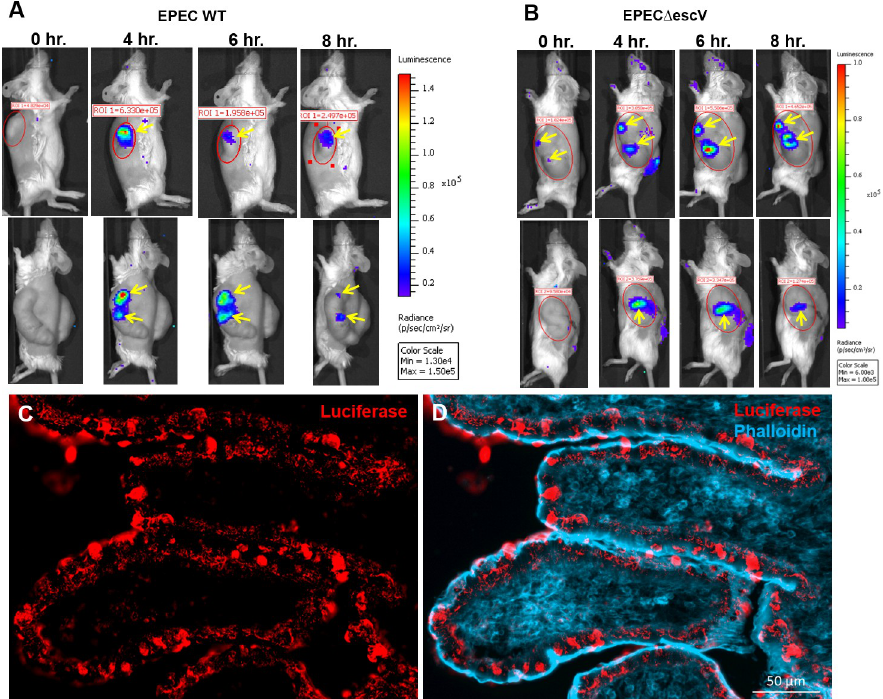
Fig 4. Spatial and temporal activity of NF- κ B in steady state and inflamed human gut activated by luminal E . coli bacteria. Human fetal gut was transplanted into two SCID mice and allowed to develop over 12 weeks. The reporter system and intravital imaging were performed as described above (see Fig 1). Time course of the luminescence activity before activation (0 hr. in A-B) and 4–8 hours (A-B) after activation following intraluminal infusion of Enteropathogenic E. coli O127 wildtype (WT) strain (A) and the T3SS-defective isogenic Δ escV mutant strain (B). Focal activity in steady state was visible in one transplant (yellow arrow in B) following luciferin injection. Luminescence imaging demonstrating focal activity of NF- κ B discretely activated 4–8 hours following intraluminal infection with WT or mutant bacterial strains (yellow arrows in A-B). The expression of luciferase human gut transplant 8 hours after infection with WT bacteria was imaged using immunostaining and fluorescence microscopy (C-D). Representative images of fluorescence staining of cryosections using anti-luciferase antibodies (red in C-D) and phalloidin (blue in D). Luciferase expression is limited to mucosal villous epithelial cells. Scale bars, 50 μ m (C-D). Representative results of one experiment out of five similar experiments.